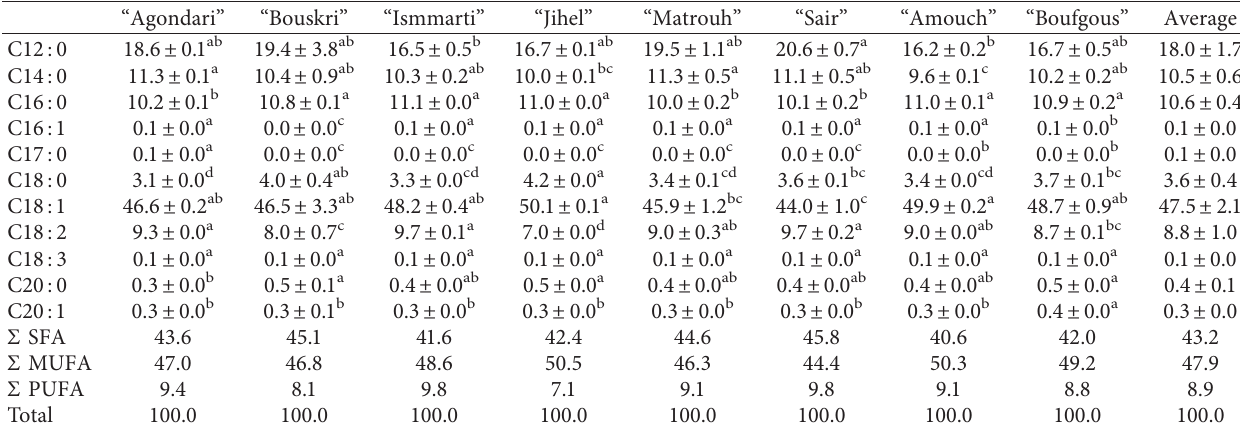
Table 4: Mean values of fatty acids (in %) of date seed oils from eight date palm Moroccan varieties. All values are mean ± standard deviation of three replicates. Different letters within a column indicate significant statistical differences ( p < 0 . 05). SFA:saturated fatty acids, MUFA: monounsaturated fatty acids, and PUFA: polyunsaturated fatty